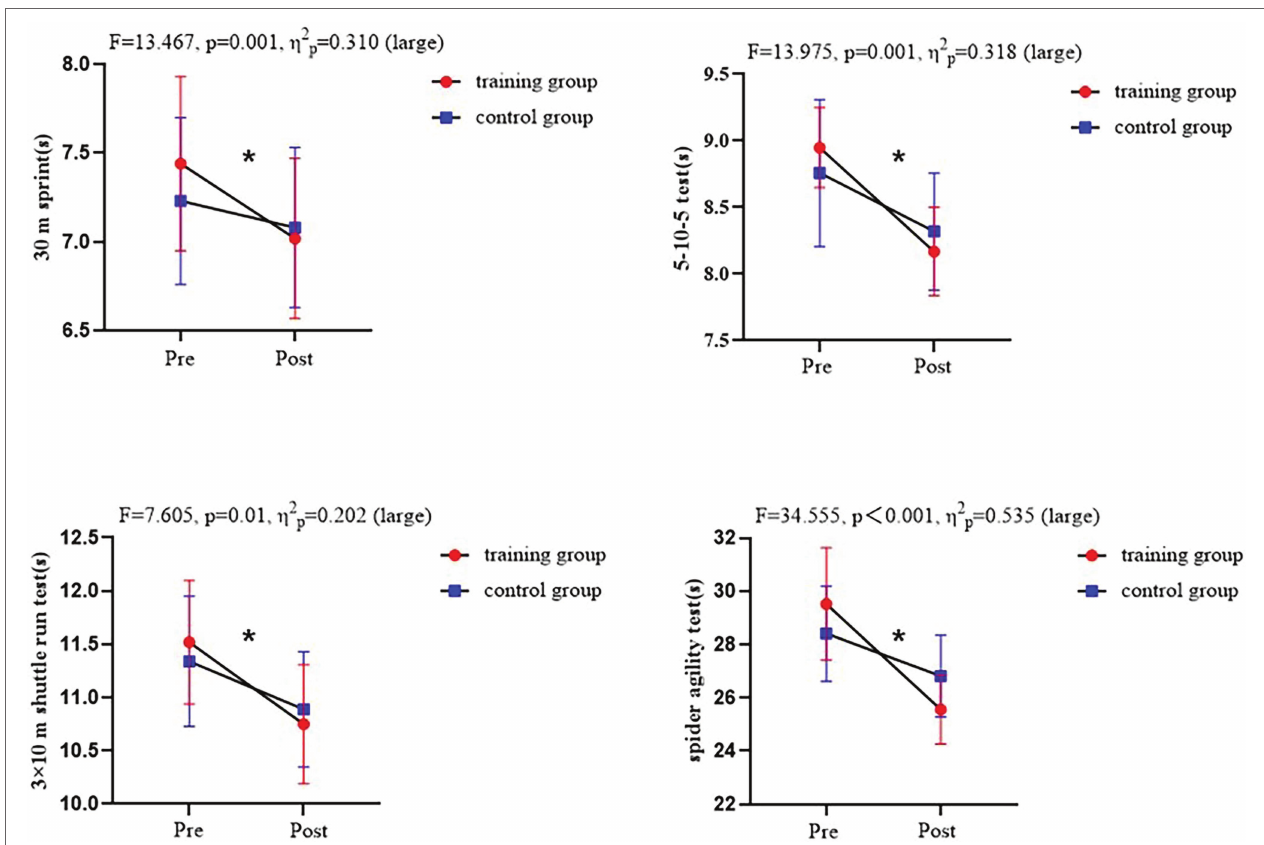
FIGURE 1 | Comparison of training group and control group pre-and post-intervention. *Significant difference from pre-test within the